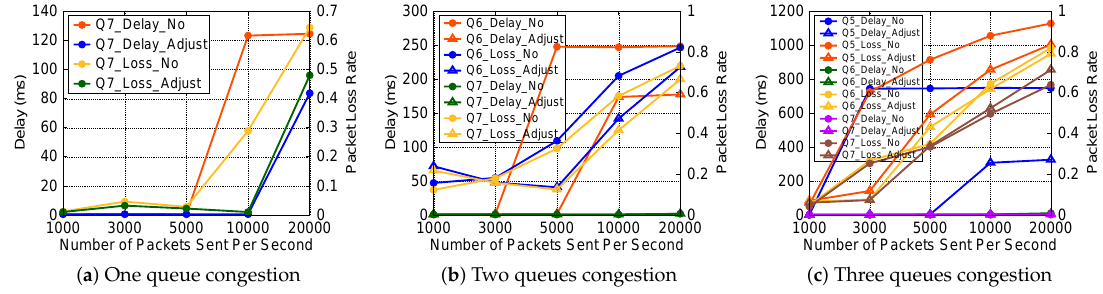
Figure 6. Local queue bandwidth adjustment algorithm verification.